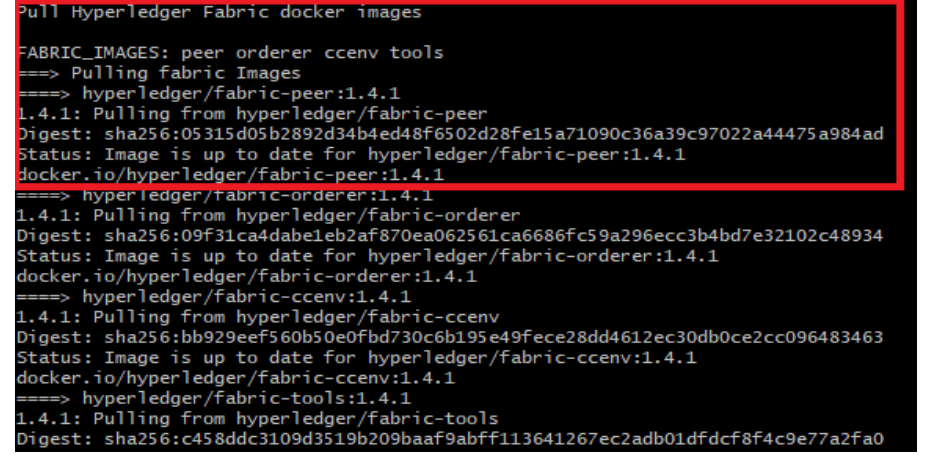
Figure 20 . Create peers in